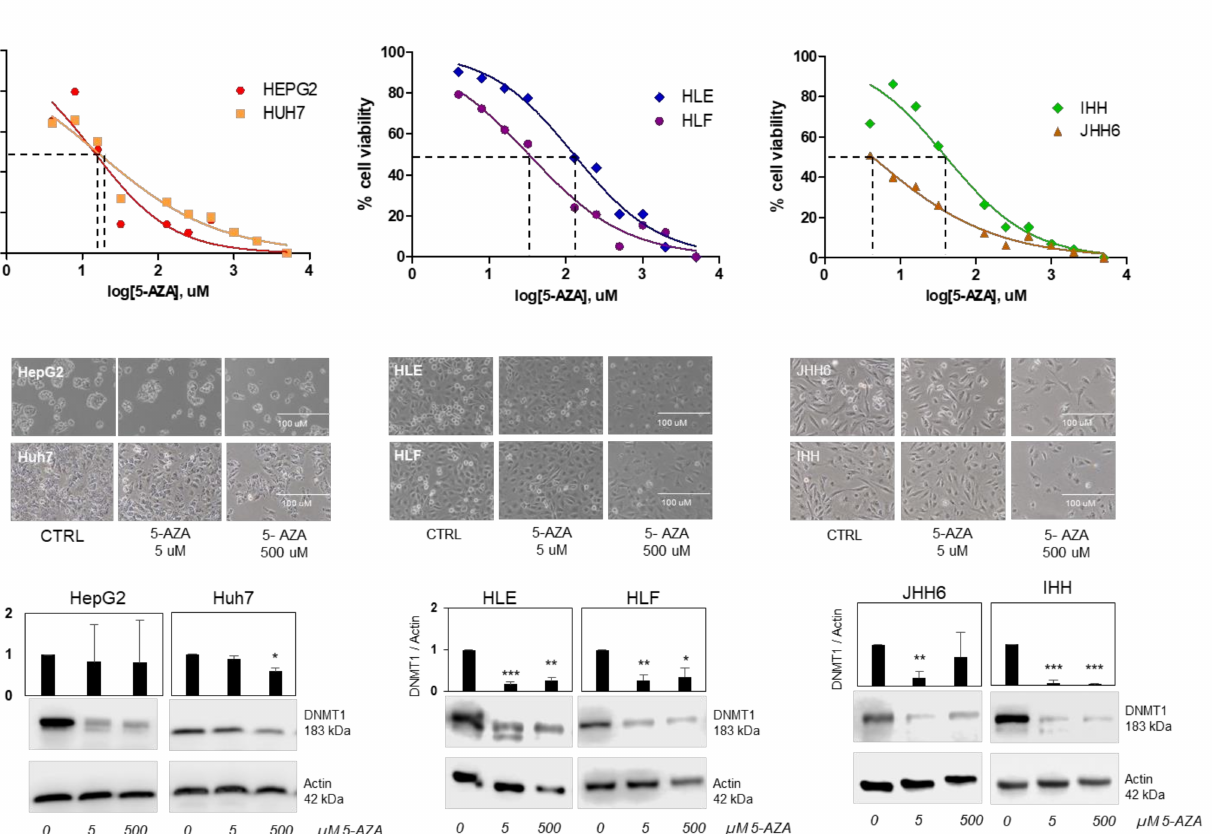
Figure 2. The effect of 5-Azacytidine (5-AZA) in in vitro models. ( A ) Dose response of hepatic cell lines: CSC HCC cells: HepG2 and Huh7; stromal HCC cells: HLE, HLF, and JHH6, and immortalized hepatocytes IHH. All cells were treated with 2 µ M to 5 mM of 5-AZA for 24 h and cytotoxicity assay was performed by MTT test. Dashed lines show LC 50 value for each cell line. ( B ) Cells morphology after 24 h treatment of 5 µ M and 500 µ M of 5-AZA. ( C ) Quantitative graphs and representative blots of DNMT1 protein expression (183 kDa) after 24 h treatment of 5 µ M and 500 µ M of 5-AZA. Actin (42 kDa) was used as housekeeping protein. Graphs presented as mean ± SD calculated from at least three independent experiments. Statistical analysis: * p < 0.05, ** p < 0.01, *** p < 0.001 using Student’s t-test relative to CTRL (0 uM) in each cell line. MTT: 3(4,5-dimethyl thiazolyl-2)-2,5